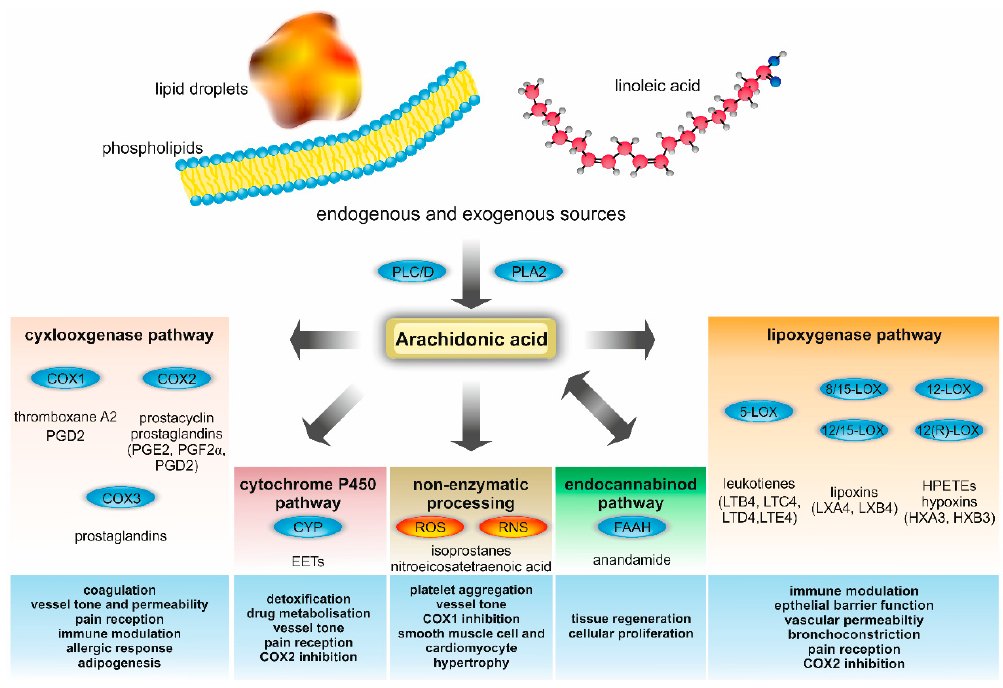
Figure 1. Metabolites and enzymes involved in AA metabolism and their biological functions in metabolic and cardiovascular diseases. Endogenous AA is mainly derived from cell membrane phospholipids, which are processed by phospholipase A2 (PLA2), phospholipase C (PLC), and phospholipase D (PLD). Free AA serves as a precursor for a plethora of metabolites, including prostaglandins (PGs), prostacyclin, thromboxane, HPETE, leukotrienes, lipoxins, hypoxins, anandamide, and epoxyeicosatrienoic acids (EETs). In addition to this enzymatic processing of AA, there is also a non-enzymatic metabolization. The latter is important for the production of isoprostanes and nitroeicosatetraenoic acid. Many AA metabolites are highly bioactive and involved in various crucial vital processes. Relevant biological functions in metabolic and cardiovascular diseases are summarized in the blue boxes at the bottom. Additional abbreviations used: COX, cyclooxygenase; CYP, cytochrome; ROS: Reactive oxygen species; RNS: Reactive nitrogen species; FAAH, fatty acid amide hydrolase; HX, hypoxin; LOX, lipoxygenase; LT, leukotriene; and LX, lipoxin.